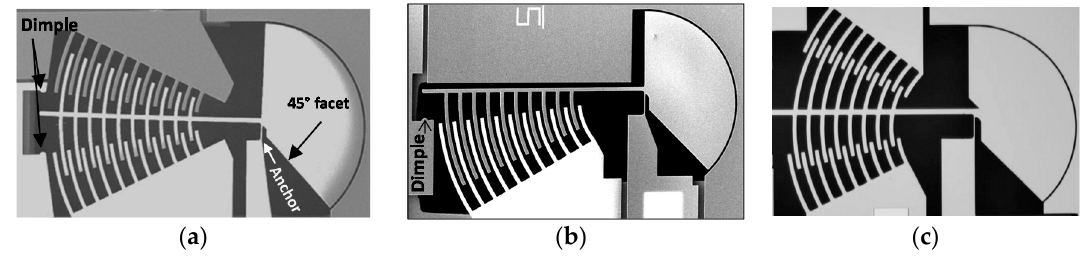
Figure 2. Micrographs of: ( a ) the initial design, ( b ) the 2nd version one-sided optimized actuator design, and ( c ) the 3rd version two-sided actuator design.